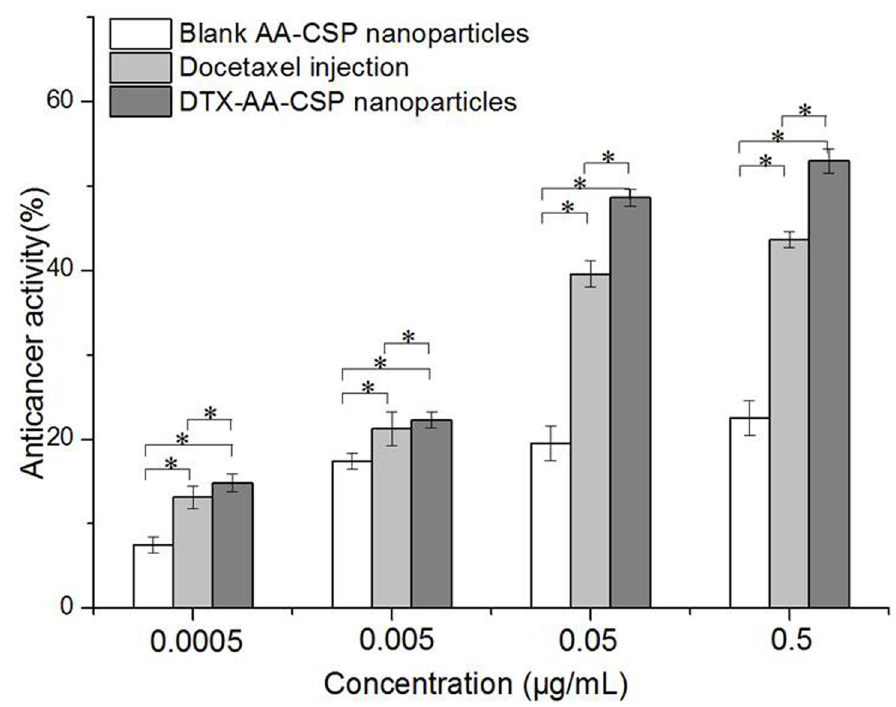
FIGURE 9 - Anticancer activity of AA-CSP nanoparticles, docetaxel injection (Taxotere ® ) and DTX- AA-CSP nanoparticles on SW 480 cells after 48 h incubation (* p < 0.05).